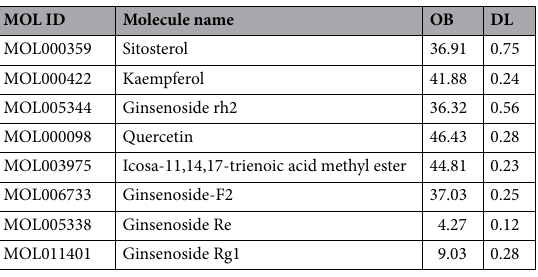
Table 1. Core components of panax ginseng leaves.